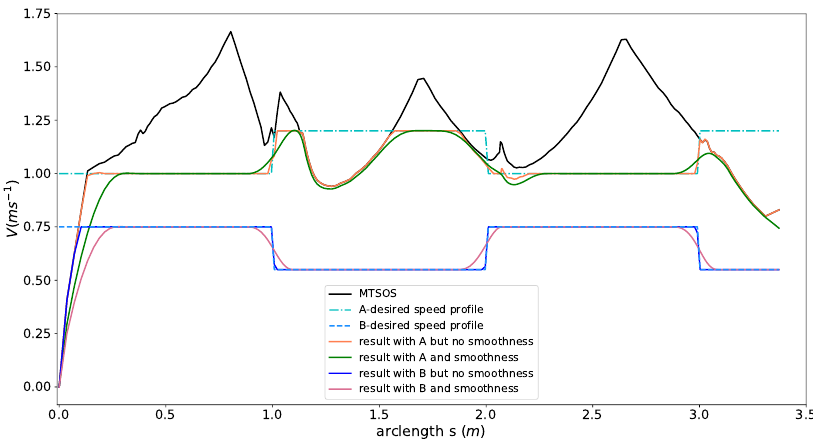
Figure 10. Speed planning results with desired speed in different shapes.